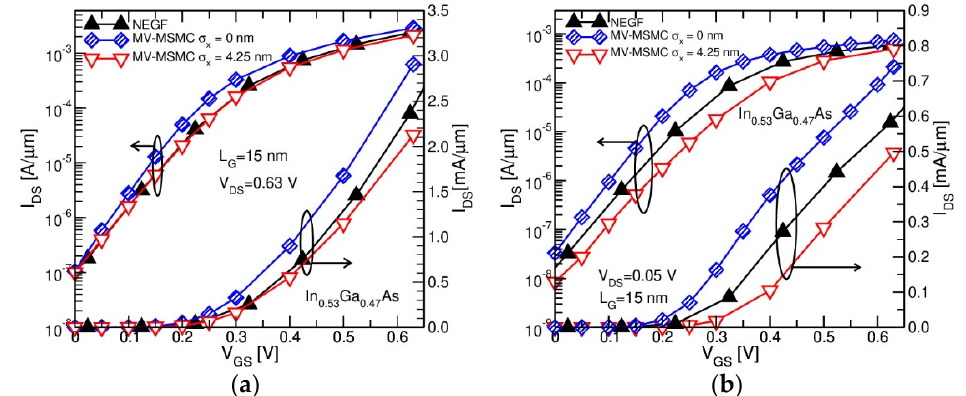
Figure 5. I DS -V GS comparison between NEGF (Non-Equilibrium Green’s Function) (ascending triangles) and MV–MSMC (multi-valley/multi-subband Monte Carlo) simulations using σ = 0 nm (diamonds) and σ = 4.25 nm (descending triangles) for an InGaAs n-MOSFET with L G of 15 nm. V DS is 0.63 V for ( a ) and 50 mV for ( b ).